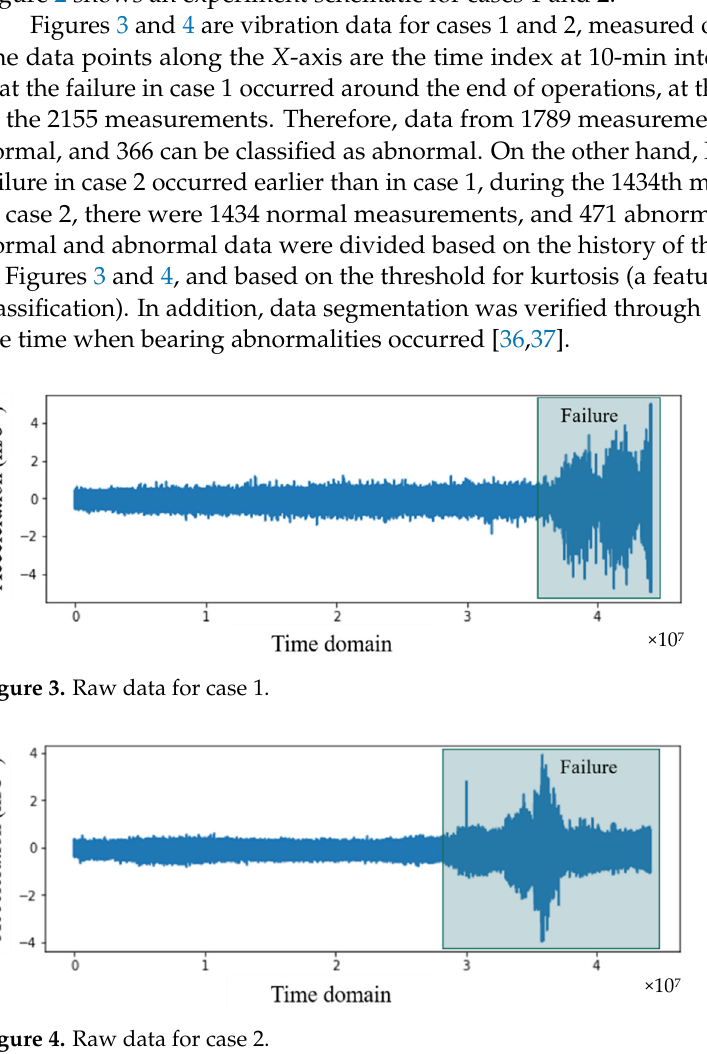
Figure 4. Raw data for case 2.